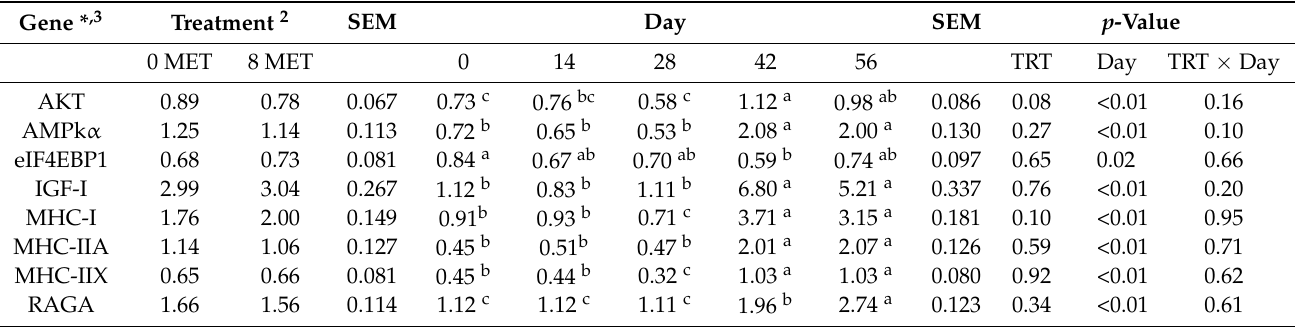
Table 7. Effect of encapsulated amino acids on relative mRNA abundances of AKT, AMPK α , eIF4EBP1, IGF-I, MHC-I, MHC-IIA, MHC-IIX, and RAGA genes in longissimus tissue 1 . Gene * ,3